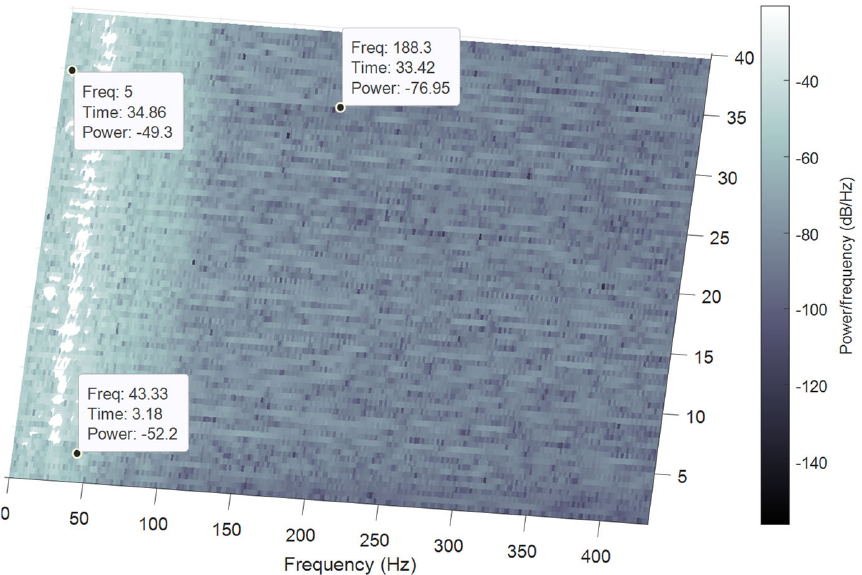
Figure 11. Spectrogram of the denoised SCG signal in the second adaptive filter output after indi ‐ Figure 11. vidual adjustment.